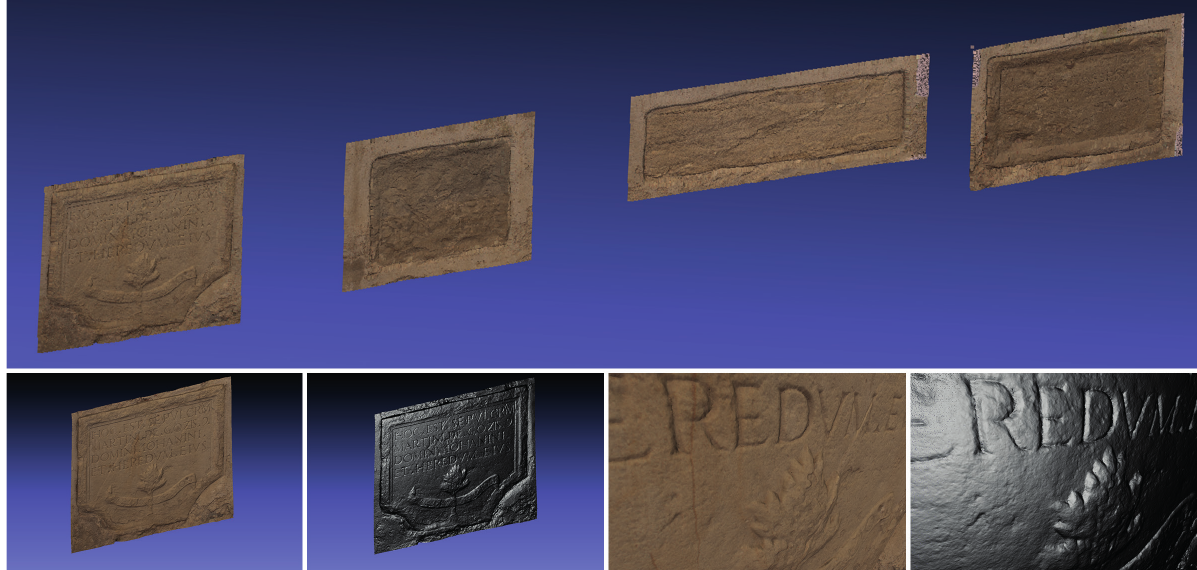
Figure 13. Phase 03 : the photogrammetric models of the epigraphs: RGB (rendering with texture) and RTI (with normals